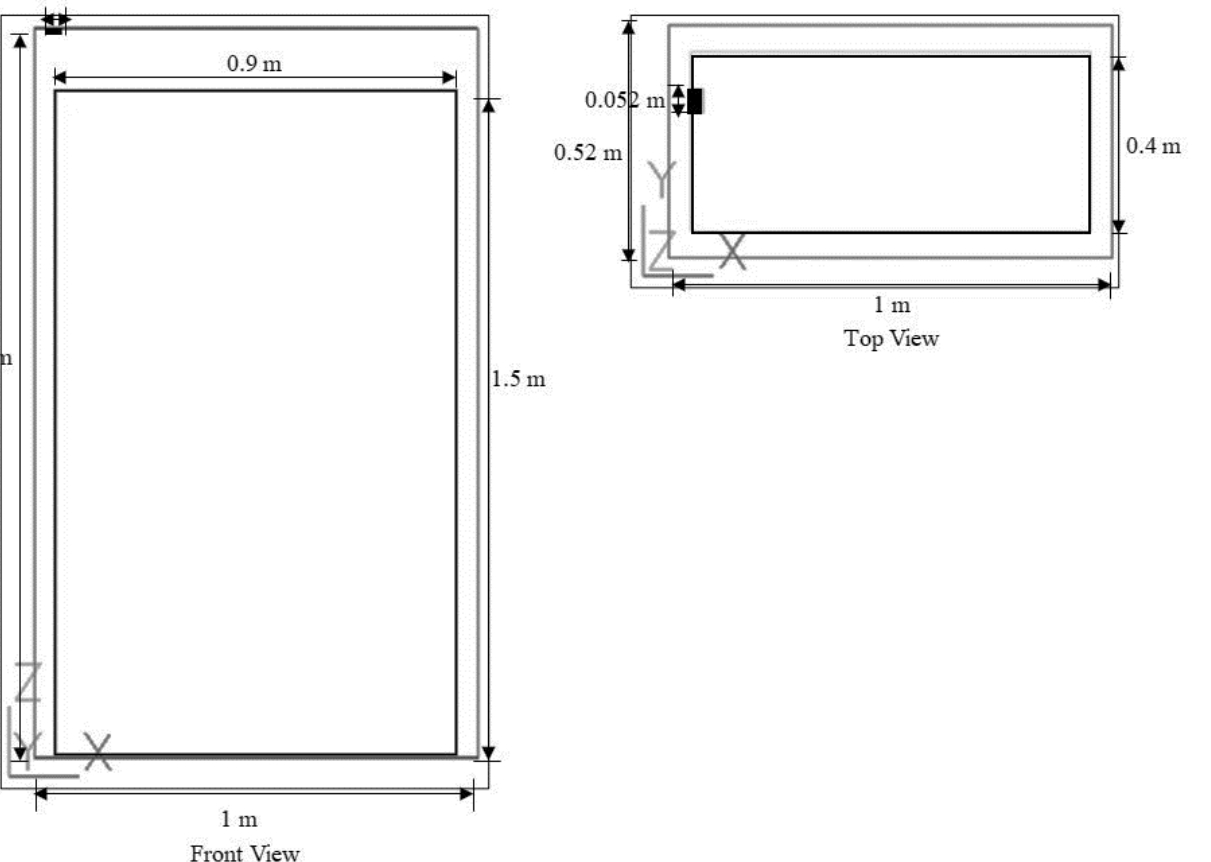
Figure 4. Chamber model: Fans are placed at the top left side of the chamber ( ▃ represents the fan). The rectangular shape inside of the chamber represent the plant.